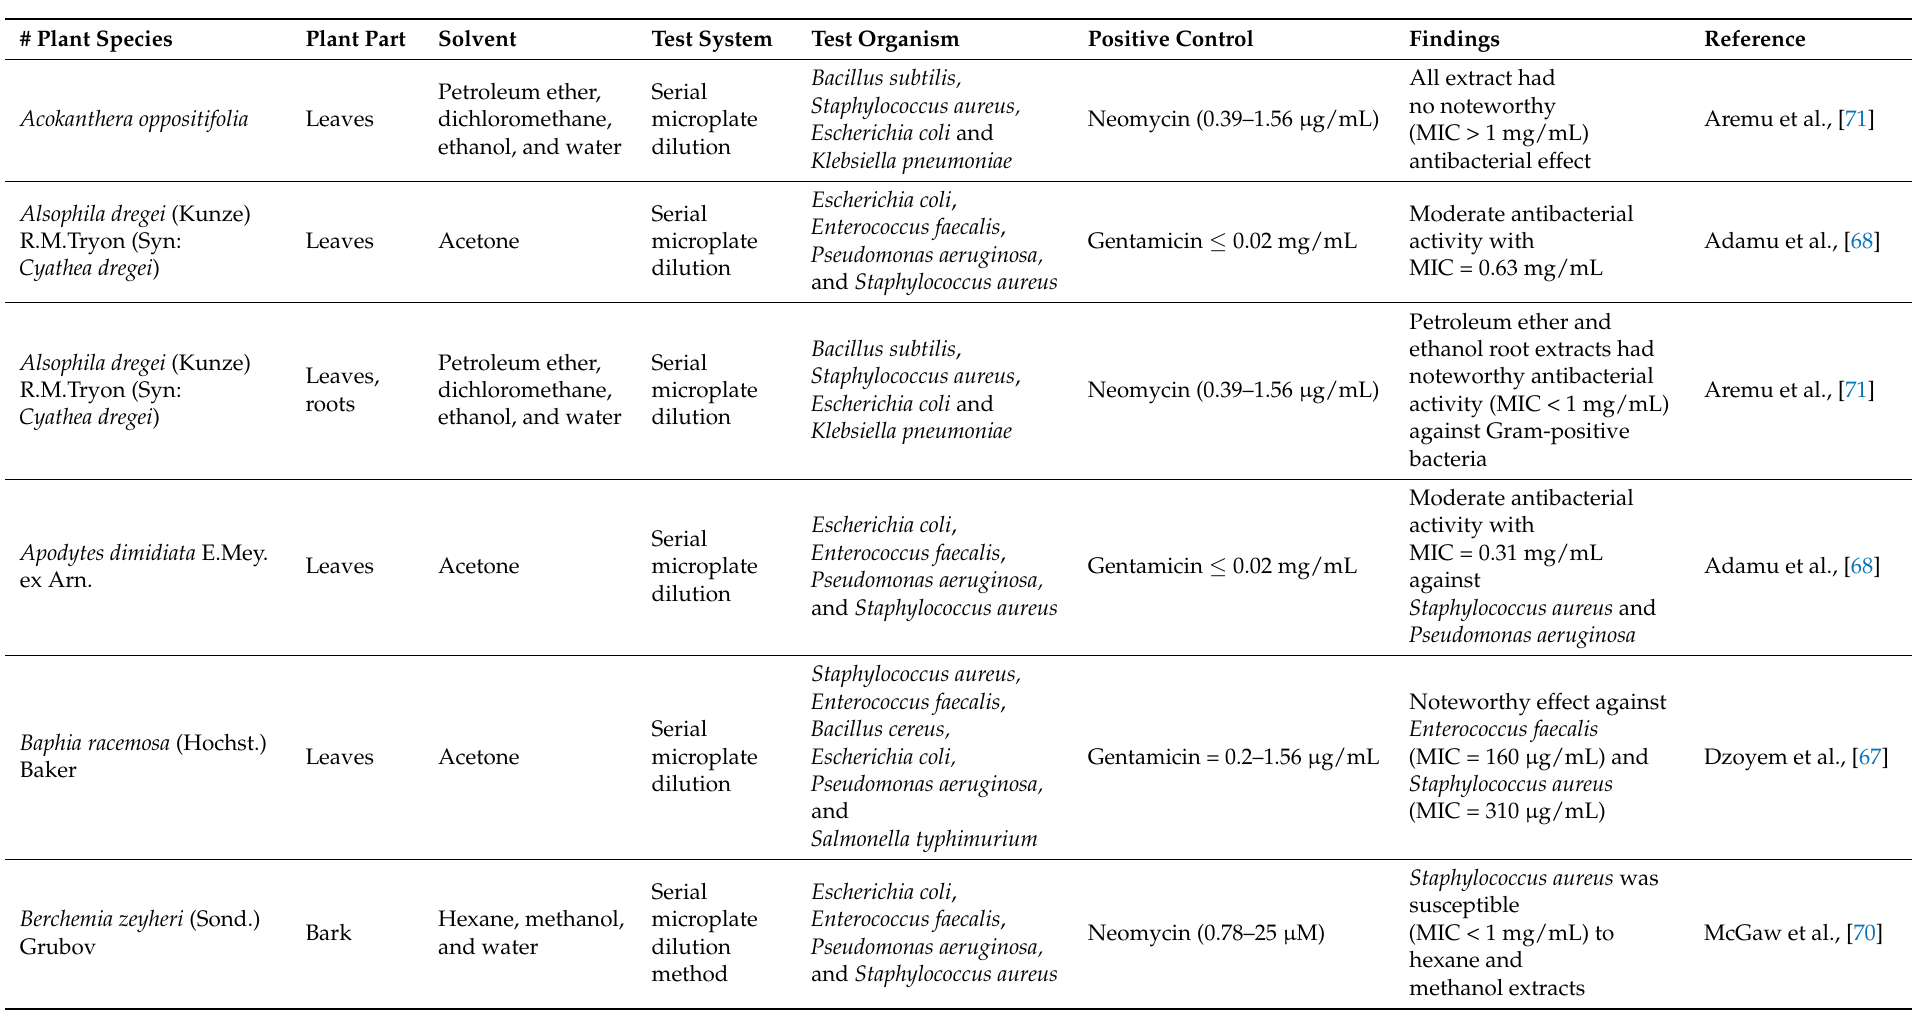
Table 3. Examples of in vitro antibacterial activity of woody plants with ethnoveterinary applications in South Africa. # Plant species: denotes woody plants with ethnoveterinary uses in Table 2; MIC—minimum inhibitory concentration, ns—not